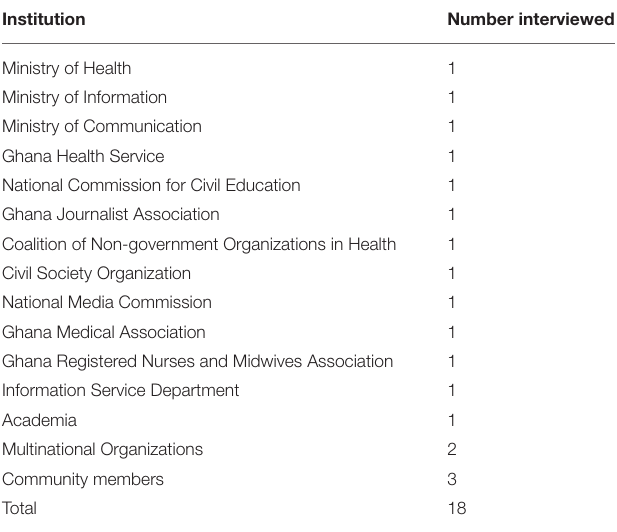
TABLE 1 | Institutions where participants were selected for the